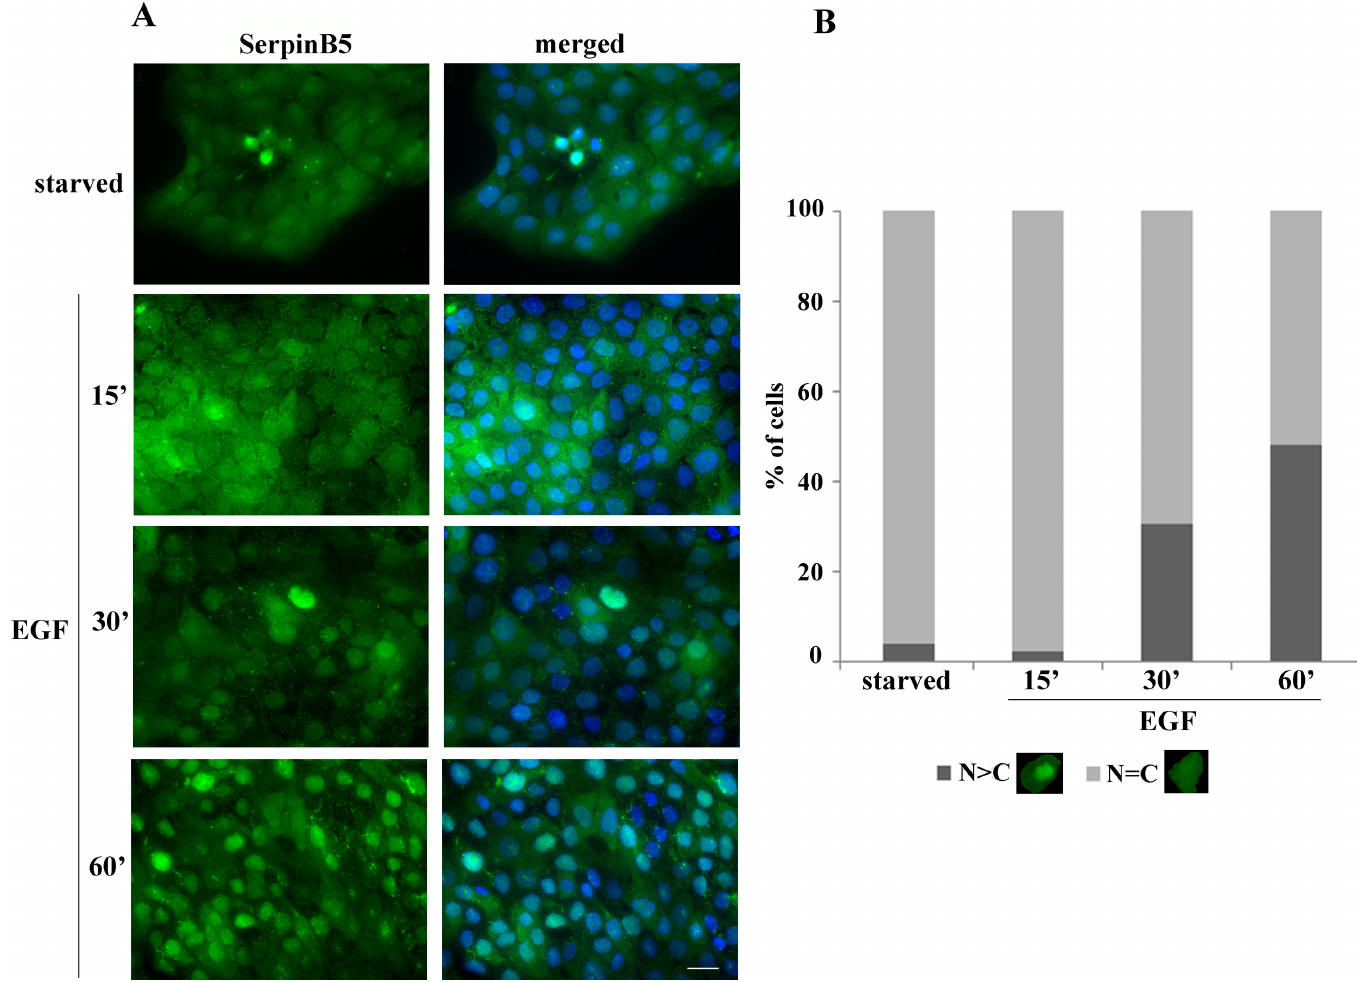
Fig 5. EGF treatment leads to SerpinB5 nuclear accumulation in MCF-10A cells. A. Starved MCF-10A cells were treated with 20 ng/ml of EGF for the indicated periods of time. Cells were fixed and processed for immunofluorescence with anti-SerpinB5 (Sigma). Nuclei were stained with DAPI. Bar, 50 μ m; B. Cells were quantified based on the criteria shown under the graph. Approximately 130 cells from four random views were quantified. This result is representative of three independent